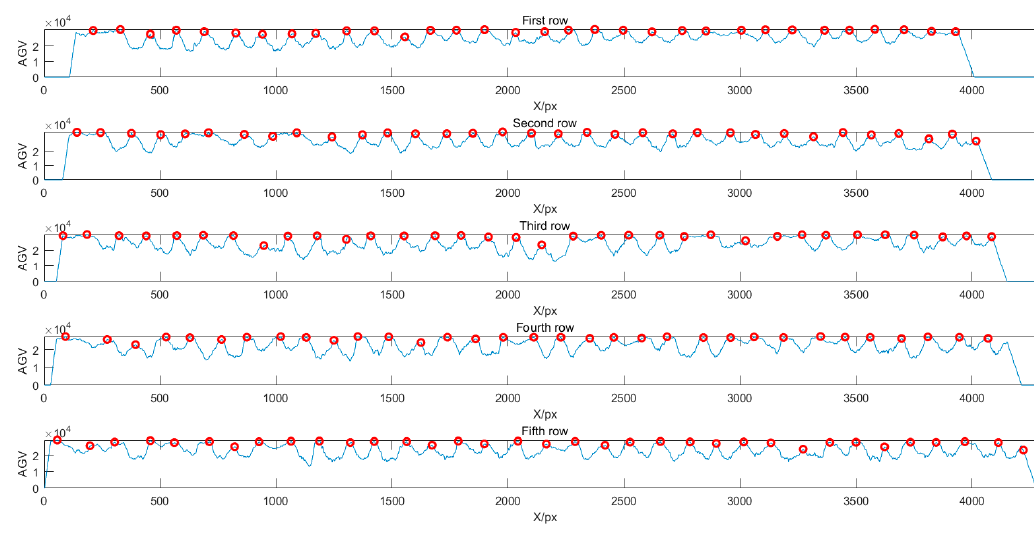
Figure 2. Row and column detection with multimodal data of orchard canopy.